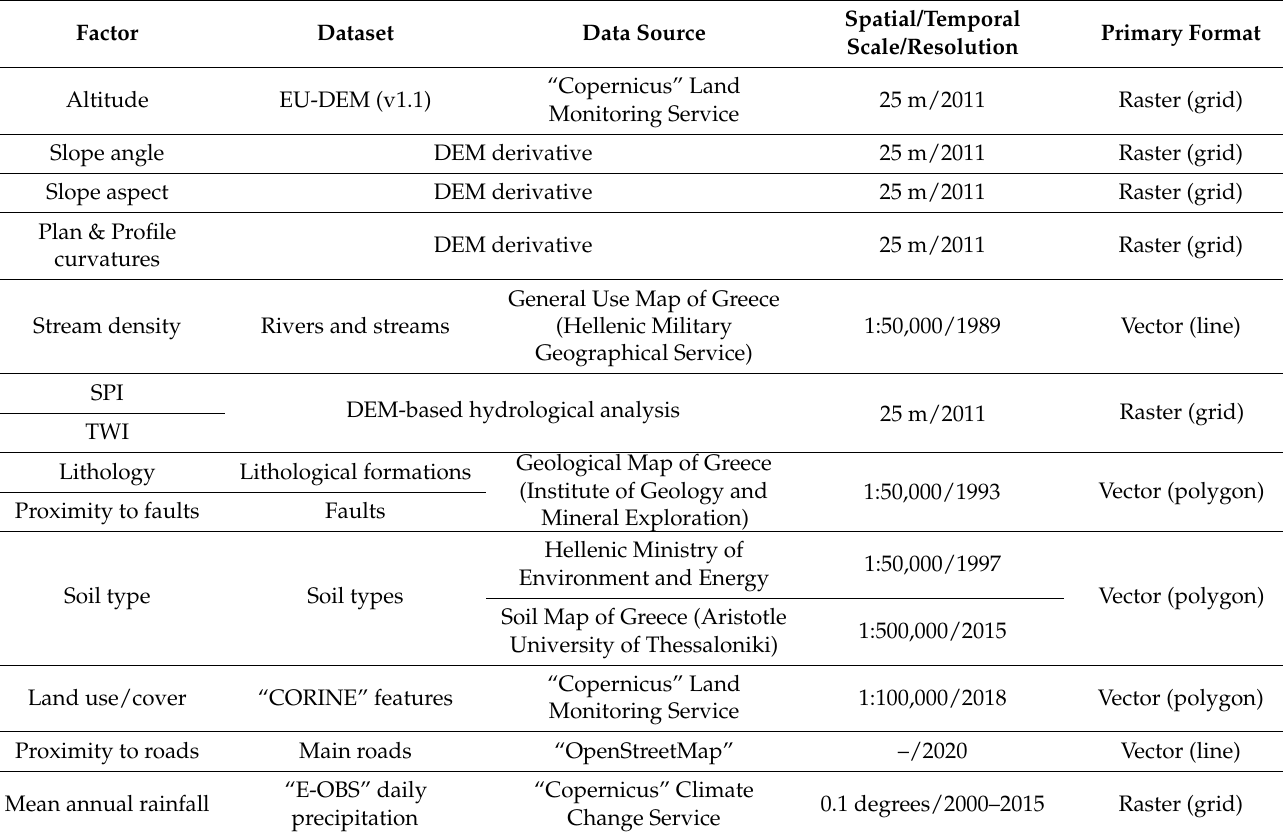
Table 2. Summary of the datasets representing the conditioning